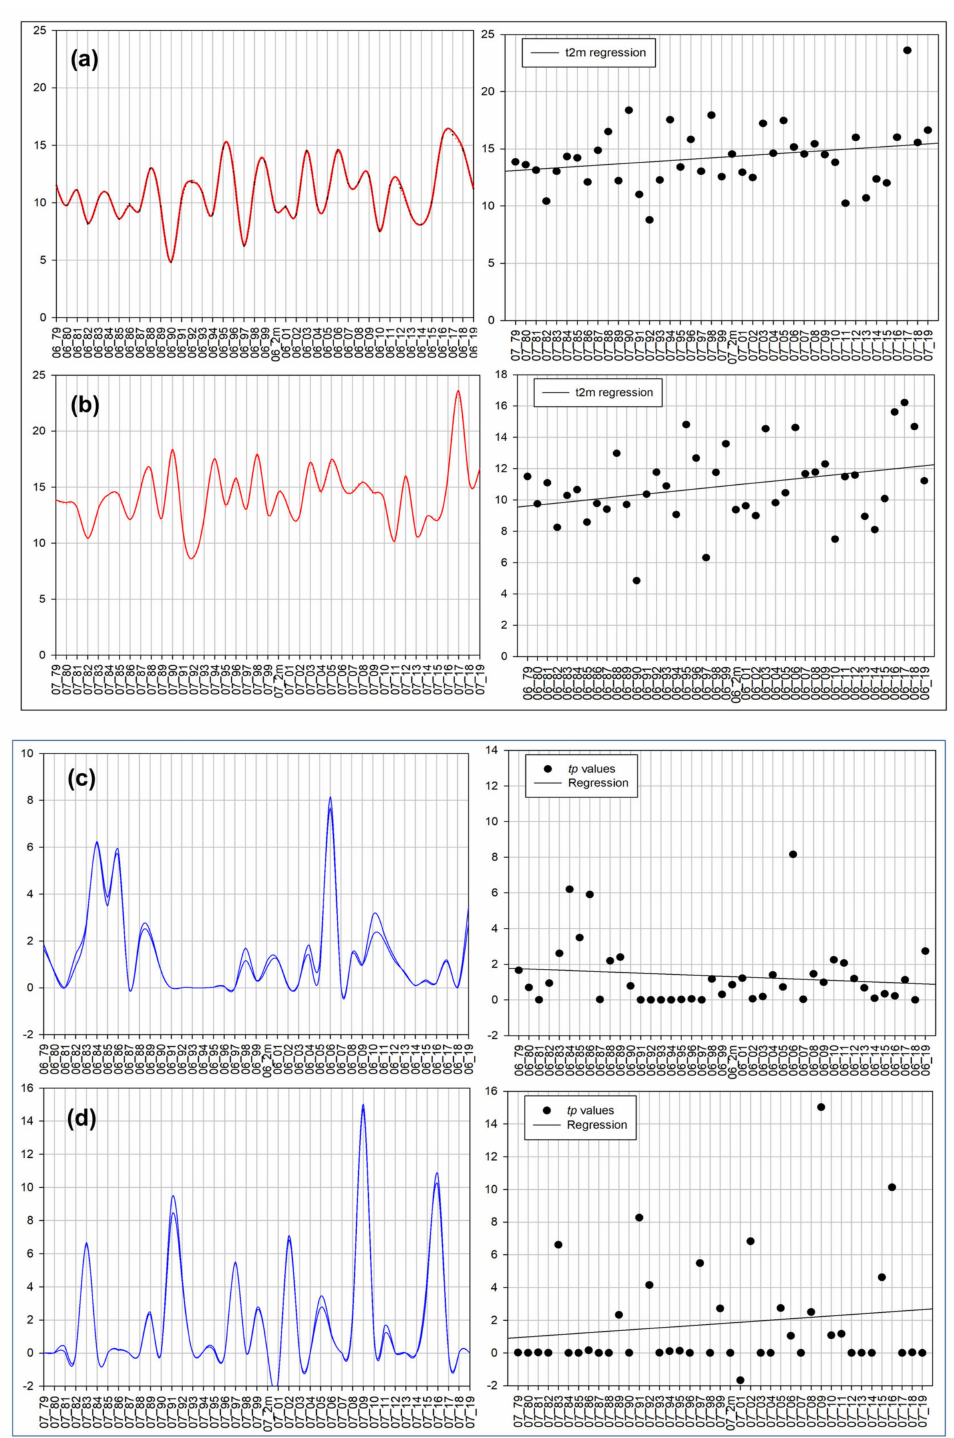
Figure 5. Processing of climate data series: t2m ( a , b ) and tp ( c , d ) plots and regression results for the months of June and July in